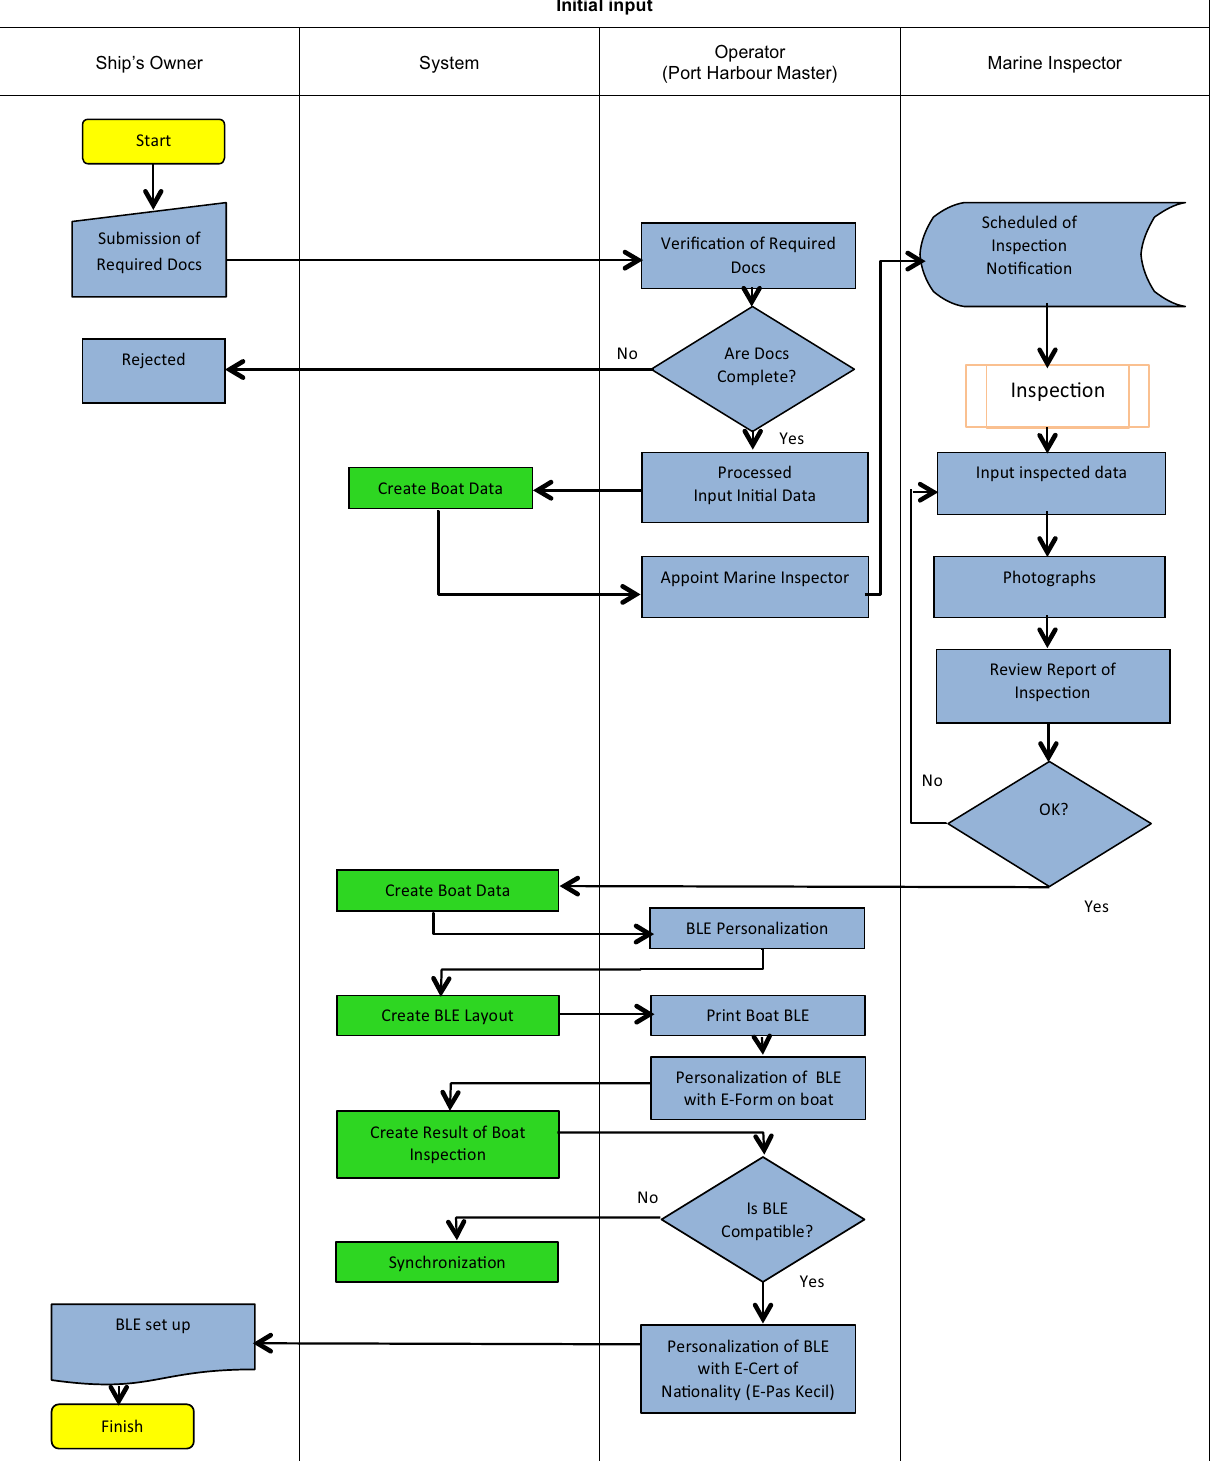
Fig. 7 Data input flow of the actors/stakeholders in boat